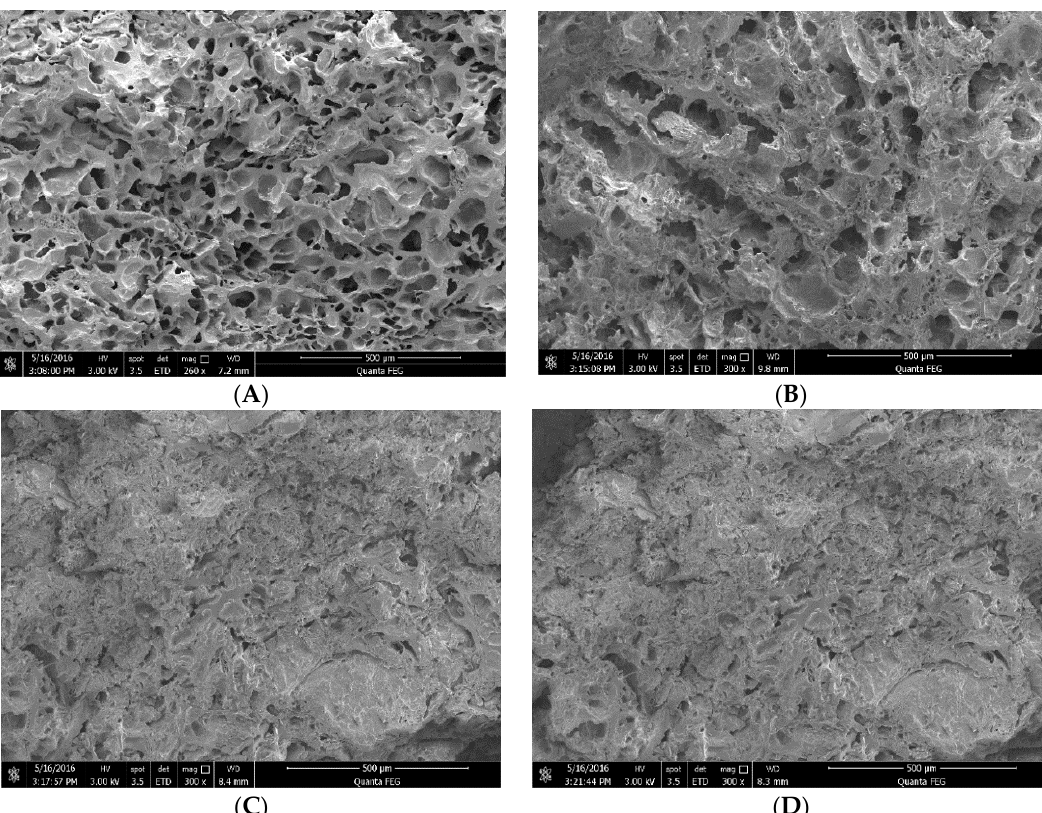
Figure 5. SEM micrographs of tortillas (with scale bars). ( A ): enzymatic wet-milling corn flour + 0.5% xanthan gum + 5% cassava starch; ( B ): enzymatic wet-milling corn flour; ( C ): dry-milling corn flour + 0.5% xanthan gum + 5% cassava starch; ( D ): dry-milling corn flour.